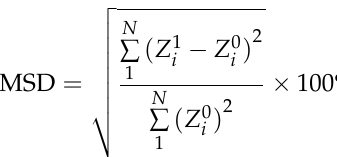
Figure 6. Impedance curve of the PZT sensors bonded on the steel plate surface of: ( a ) B ‐ type specimen (Steel ‐ UHPC) and ( b ) C ‐ type specimen (Steel ‐ NSC) under the excitation frequency band of 6000–8000 kHz.